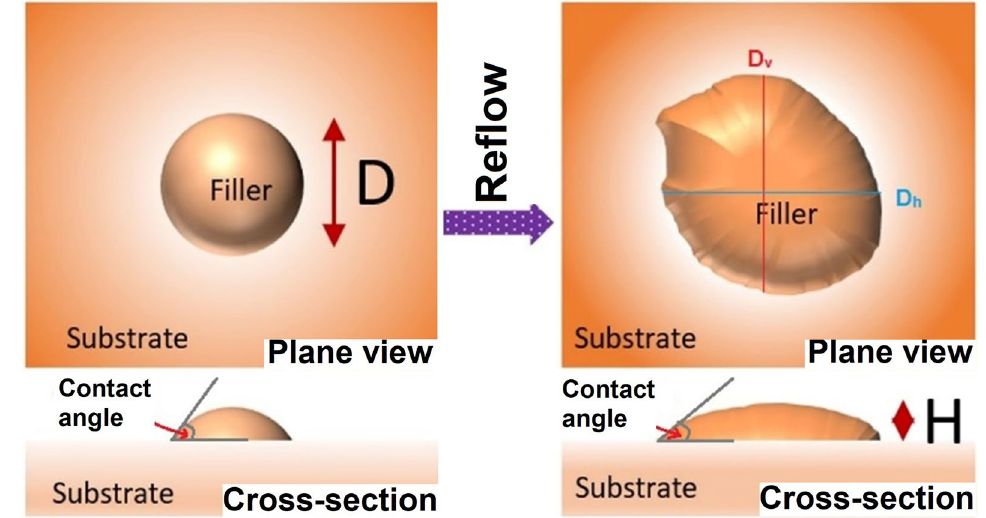
Figure 2. Schematic diagram for evaluation of filler